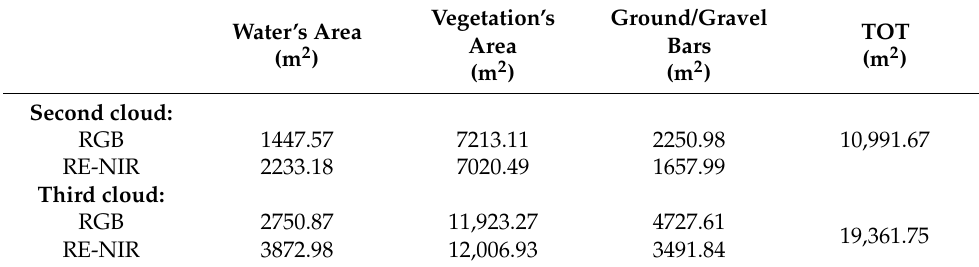
Table 6. Geometrics values observed, corresponding at RGB and RE+NIR classifications processing.